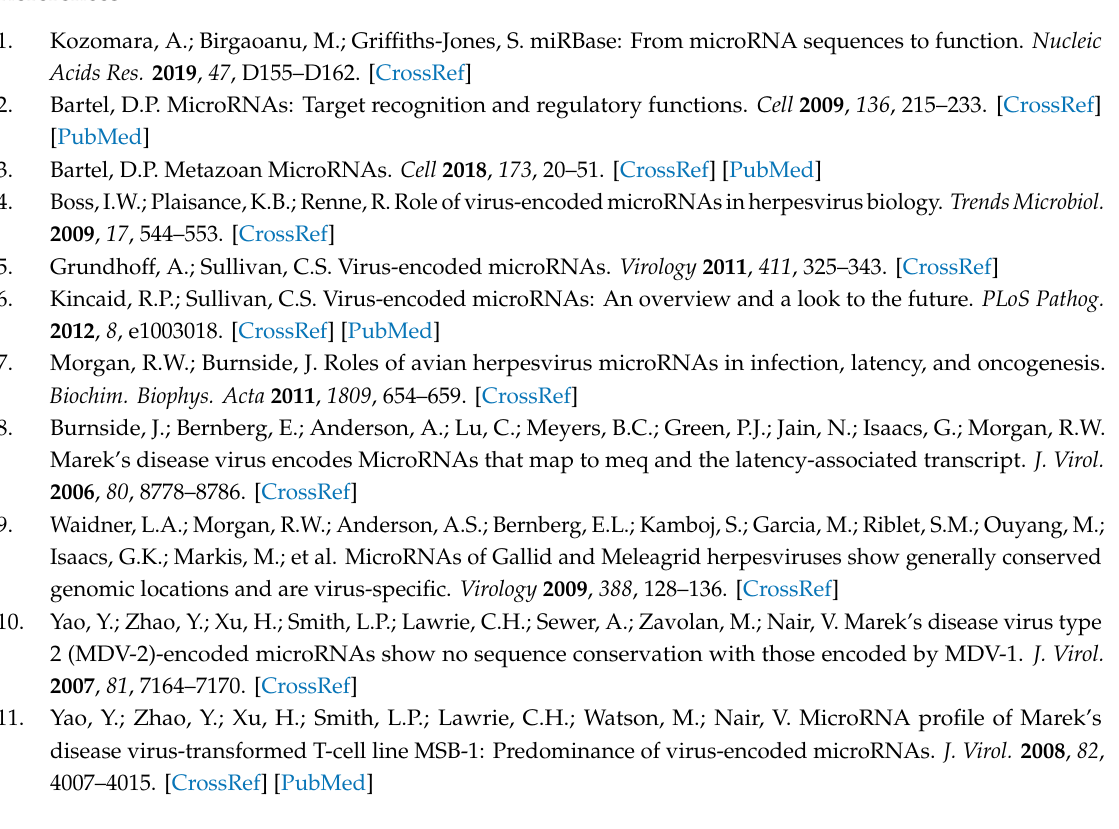
Figure S1: Sequence alignment and identification of the gRNA-mediated miRNA mutagenesis in RB-1B viral genome, Figure S2: Immunofluorescence assays for detecting the expressions of miRNA adjacent viral proteins in RB-1B mutant-infected CEF cells, Table S1: sgRNA targeting sites and PAM sequences of targeted MDV-1 miRNA genes, Table S2: Oligo nucleotides used for making sgRNA plasmid, Table S3: Primers used for PCR identification of the miRNA-deleted mutants, Table S4: Primers and probes used for real-time qPCR analysis. Author Contributions: J.L., Y.Y. and V.N. designed research; J.L., M.T., X.Z., V.R.A.P.R., Y.Y., and V.N. analyzed data; J.L., M.T., X.Z., Y.Z., N.T., A.M. and S.B. performed research; J.L., Y.Y. and V.N. wrote the paper. All